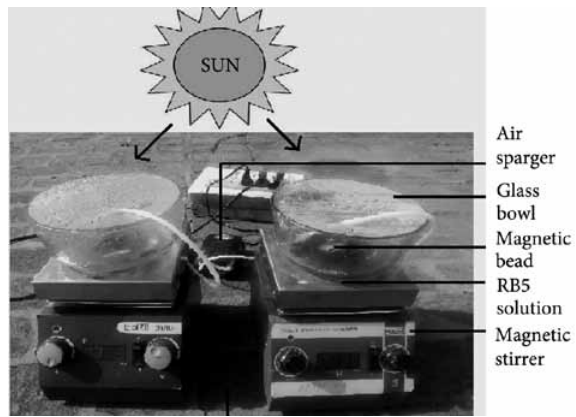
Fig. 1. Shallow pond slurry batch